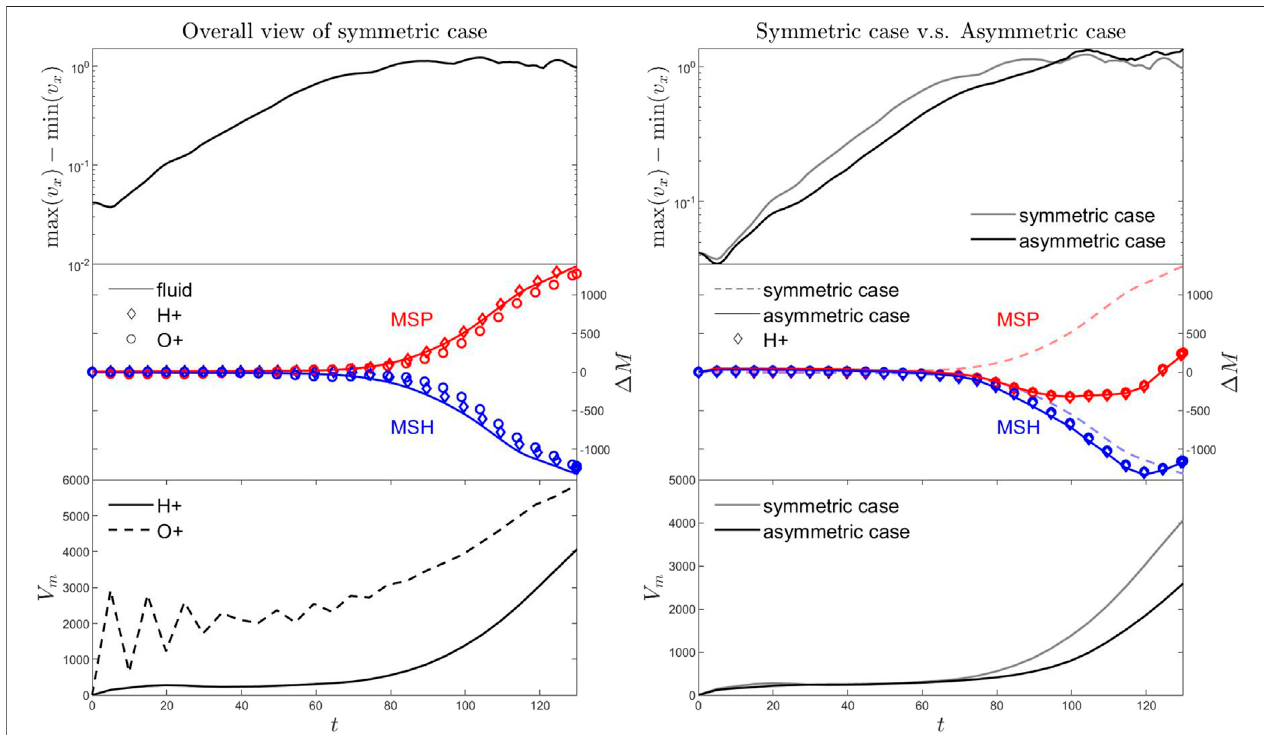
FIGURE 2 | The overall dynamical properties for the symmetric case (left) and the asymmetric case (right) . The top to bottom panels show the growth of the KH instability(therangeofthebulkvelocity v x component),thechangeofmassonthemagnetosheathside(blue)andmagnetosphericside(red), andthetotalmixedvolume V m , respectively. In the left-middle panel, the fl uid approach is represented by the solid lines and test particle approaches based on H+ and O+ are represented by diamonds and circles, respectively. In the left-bottom panel the total mixed volume is shown based on H+ (solid line) and O+ (dashed line). In the right panels, the results from symmetric case are in light gray lines or dashed lines for